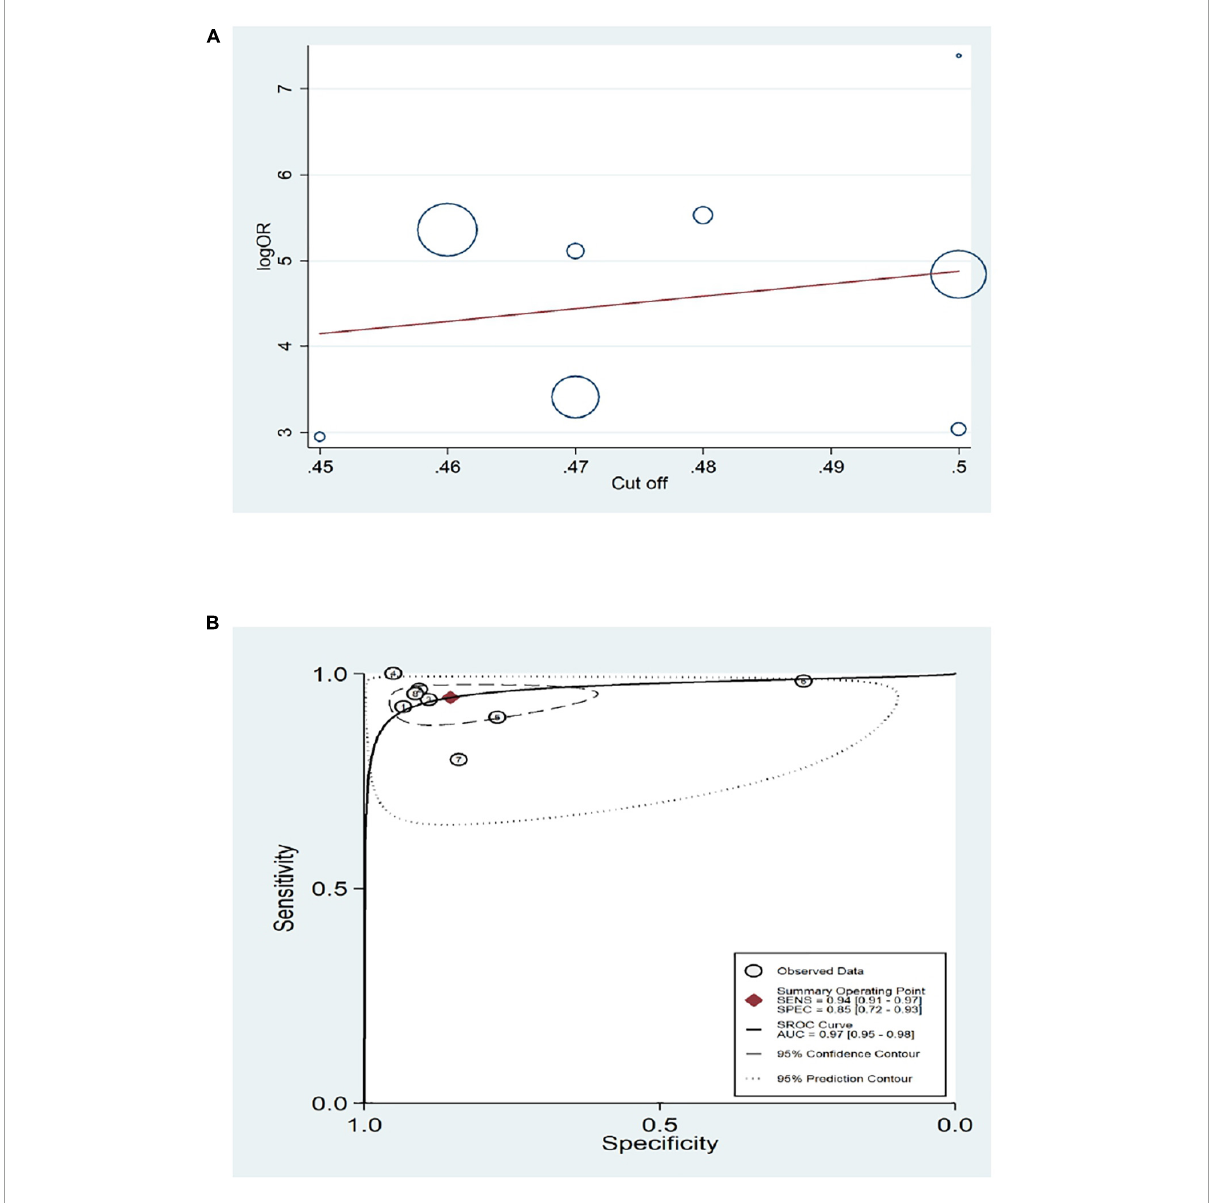
FIGURE2 Diagnostic test accuracy meta-analysis for overall optimal cutoff score of WHtR for detecting central obesity in children and adolescence. (A) Regression lines of accuracy of WHtR for children and adolescence. (B) The optimal cutoff score 0.49 was marked as a cross in the estimated SROC